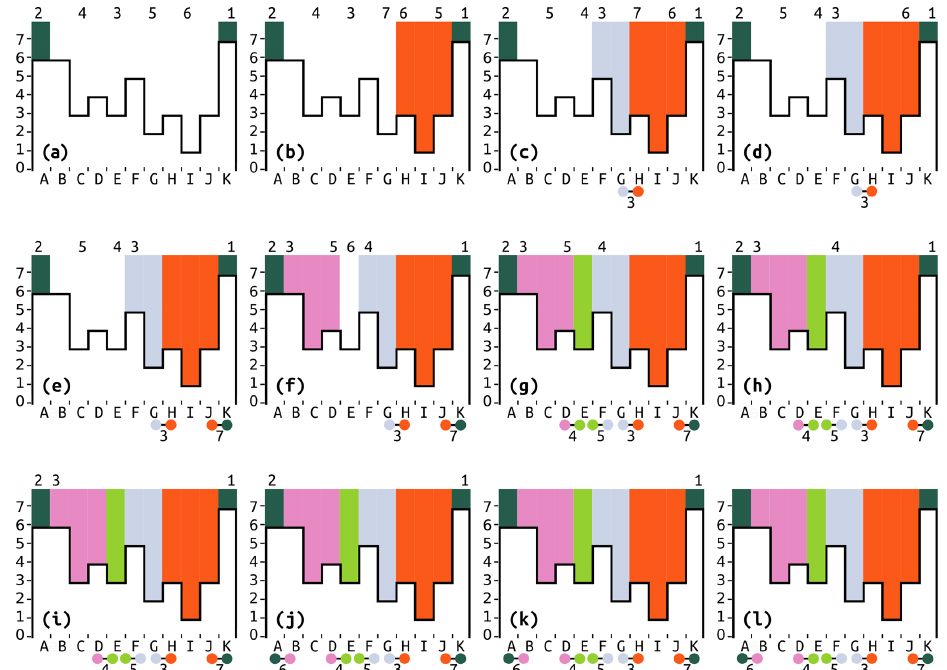
Figure 7. Illustration of the “flooding” process as applied to the right-hand side of the topography shown in Fig. 2. Boldface lowercase letters indicate progression through time. Capital letters label cells. Numbers at the top indicate the cells’ positions (if any) in a priority queue (PQ). The little barbells indicate outlets between depressions with numbers to indicate their elevations. The black lines outlining the white regions indicate elevation, with values shown on the y axis. Colors represent labels. (a) Initialization. C, E, G, and I are pit cells (they have no lower neighbors), so they are added to the PQ. A and K are ocean cells, so they are labeled as such and added to the PQ. I is the lowest cell and so has the highest priority. (b) I is popped. It is not already labeled, so it is a new depression and given a new label. H and J are labeled and added to the PQ. H and J have the same elevation as C and E, but since they have been added to the PQ more recently, their priority is higher. Arbitrarily, H is given the higher priority. (c) G is popped and given a new label. H shares I’s label, so it is ignored. F is labeled and added to the PQ. An outlet between G and H is recorded with elevation 3. (d) H is popped. It is already labeled, so it is not altered. H’s neighbors have already been labeled, so nothing is done to them. Nothing new is added to the PQ. The outlet between blue and orange has already been noted, so no new outlet is recorded. (e) J is popped. It is already labeled, so it is not altered. Its neighbor, K, has a different label (ocean), so an outlet of elevation 7 between the two depressions is noted. (f) C is popped and given a new label. B and D are a part of C’s depression, so they are given its label and added to the PQ. (g) E is popped and given a new label. It was not yet labeled, so it is given a new label. Its neighbors were already labeled, so an outlet of elevation 4 is noted between D and E, and an outlet of elevation 5 is noted between E and F. Nothing new is added to the PQ. (h) D is popped. It is already labeled, as are both neighbors. An outlet between pink and green is already recorded, so no new outlet is noted. (i) F is popped. It is already labeled, as are both neighbors. An outlet between blue and green is already recorded. (j) B is popped. It is already labeled, so it is not relabeled. An outlet to the ocean at elevation 6 is noted. (k) A is popped. It is already labeled, and the outlet between ocean and pink has already been recorded, so nothing happens. (l) K is popped. It is already labeled, and the outlet between ocean and orange has already been recorded, so nothing happens. No cells are left in the PQ, so the algorithm